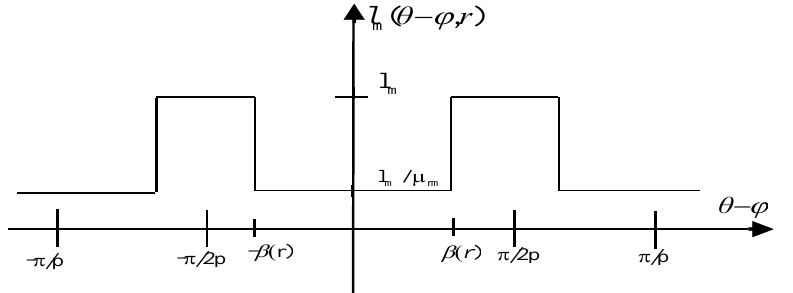
Figure 8. Equivalent function of the magnetic field force lines length in the air gap. And the function l ( θ − ϕ , r ) can be approximated as shown in Figure 9: